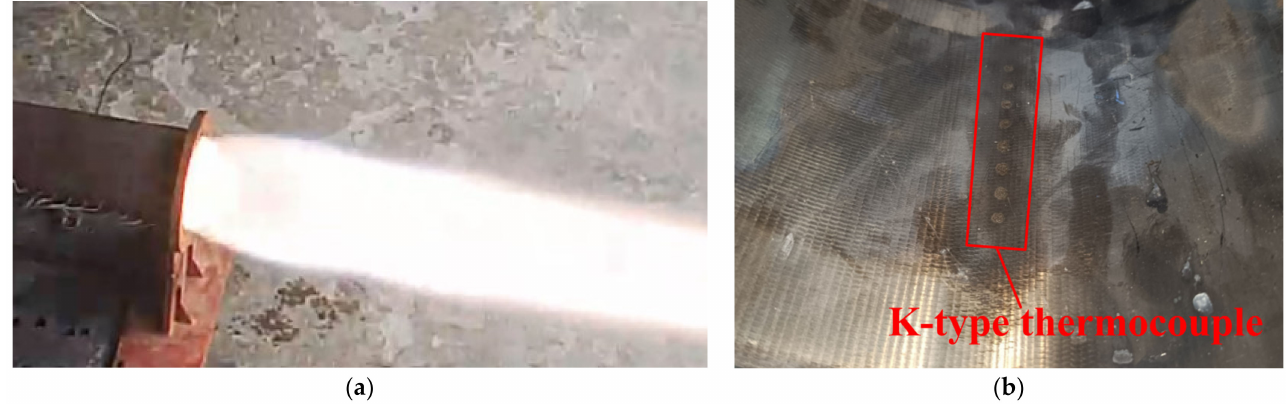
Figure 3. Experimental photos of scramjet engine and regenerative cooling: ( a ) high-temperature gas at the exhaust of a model scramjet combustor ( b ) regenerative cooling